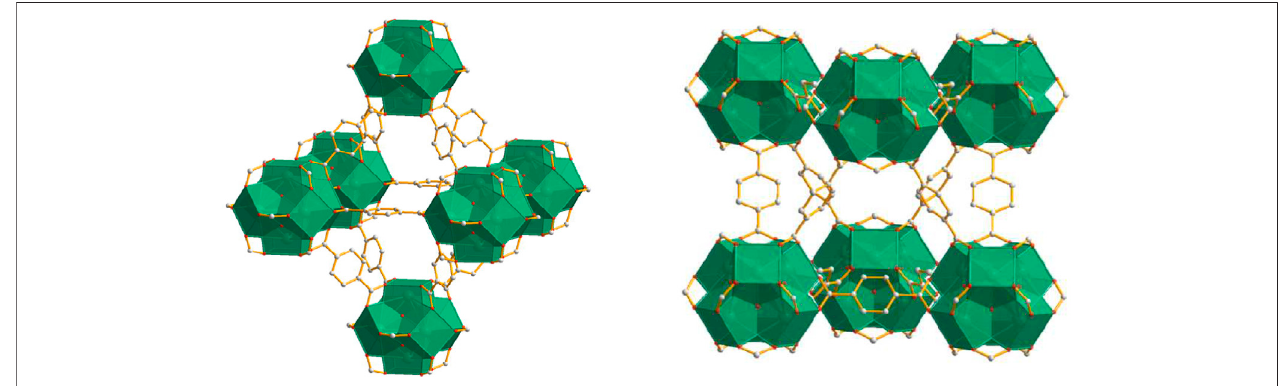
FIGURE 1 | Structure of UIO-66 (Guillerm et al., 2012; Olorunyomi et al., 2021). Gray and red balls represent carbon and oxygen atoms, respectively. Zirconium octahedral is in green. Hydrogen atoms are omitted for